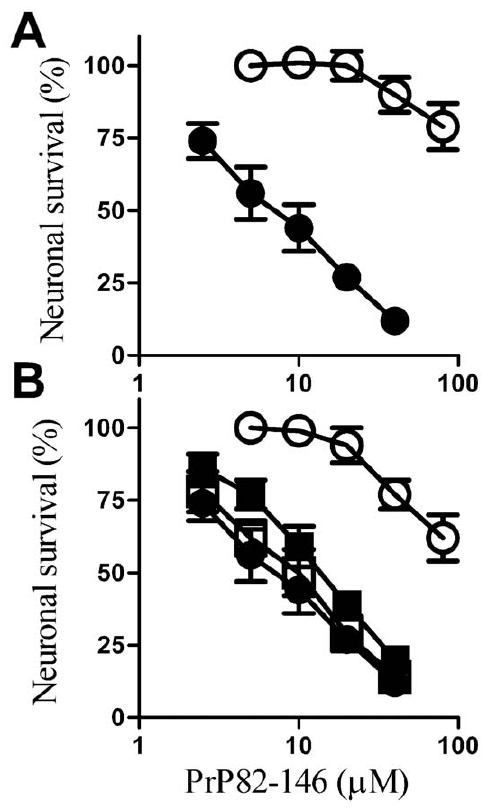
Figure 9. Digestion with PI-PLC protects neurones against PrP82–146. (A) The survival of cortical neurones pre-treated for 1 hour with 0.2 units PI-PLC/ml ( # ) or with control medium ( with varying concentrations of PrP82–146 as shown. Values shown are the mean average neuronal survival 6 SD, n=9. (B) The survival of cortical neurones pre-treated for 1 hour with a vehicle control ( 5 m M glimepiride ( # ), with 500 m M p-CMPS ( % ) or with a combination of 5 m M glimepiride and 500 m M p-CMPS ( & ) and incubated with varying concentrations of PrP82–146. Values shown are the mean average neuronal survival 6 SD,